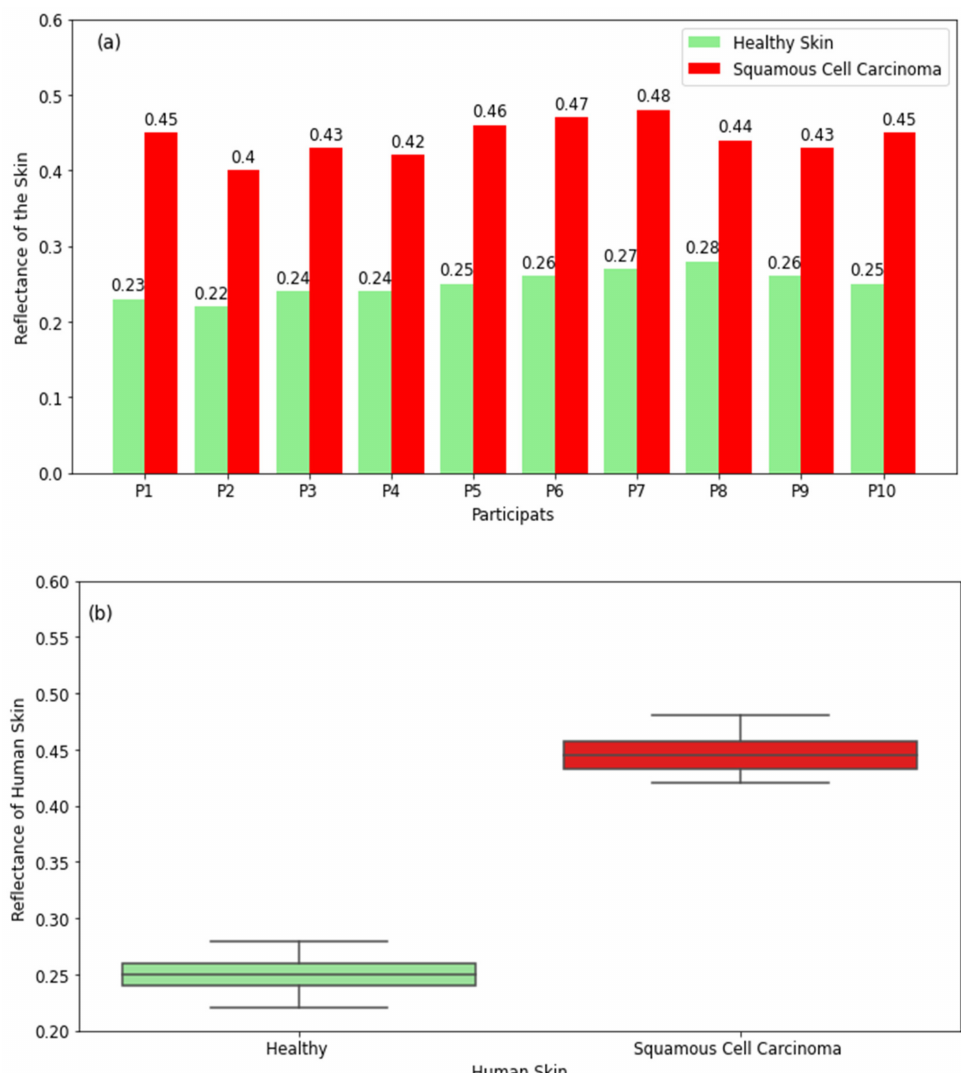
Figure 8. Reflectance measurements in a sample of 10 participants with squamous cell carcinoma compared with the closest region of healthy skin on the same participant ( a ). The boxplot shows the range in the reflectance of healthy skin and squamous cell carcinoma ( b